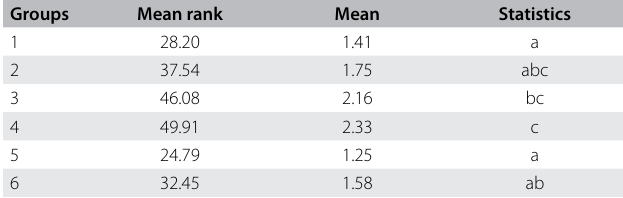
Table 3. Adhesive Remnant Index (ARI) scores and statistical comparison